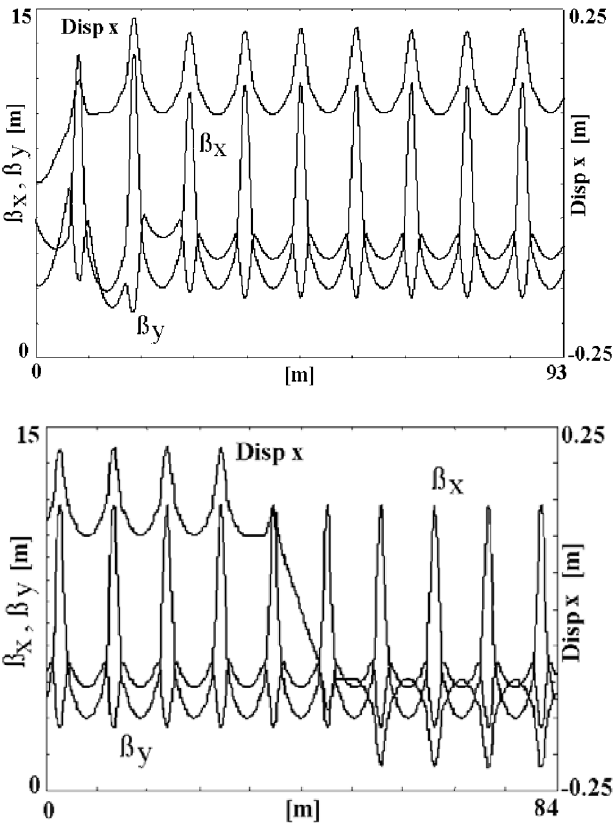
FIG. 16. Dispersion and $ functions of a regular inward sector of the return ring (upper diagram) and the ‘‘transition’’ insert between the inward and outward cells (lower